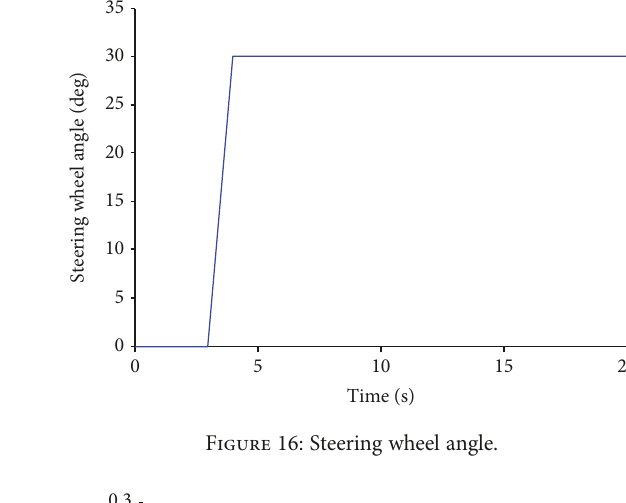
Figure 14: Comparison of vehicle yaw